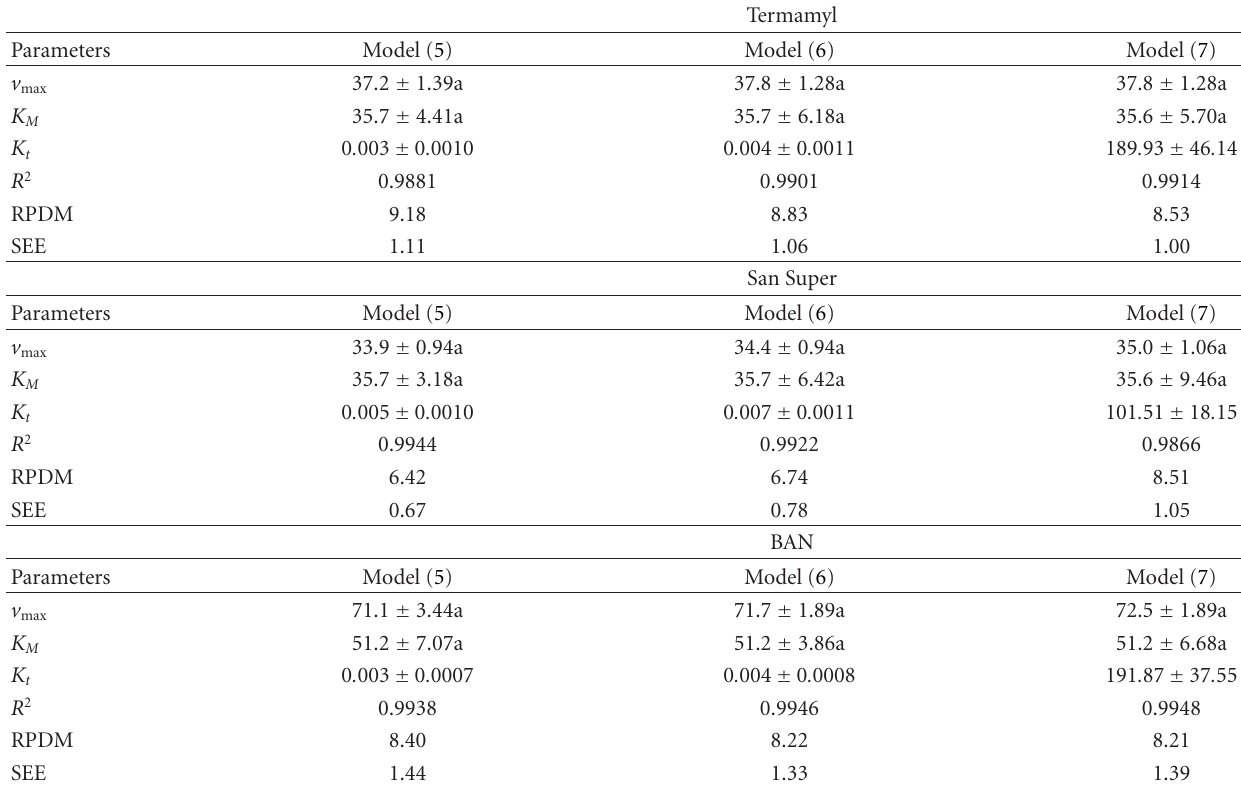
Table 2: Statistically significant ( P < 0 . 05) values (means ± standard errors) of the parameters in the overall modified Michaelis-Menten models (5), (6), and (7) for the enzymatic reactions of the three amylolytic enzymes in unaged starch and in starches aged for di ff erent times (24h, 48h, and 100 h). The mean values within rows followed by the same letter are not significantly di ff erent ( P < 0 . 05) from each other. SEE: Standard error of estimate of the